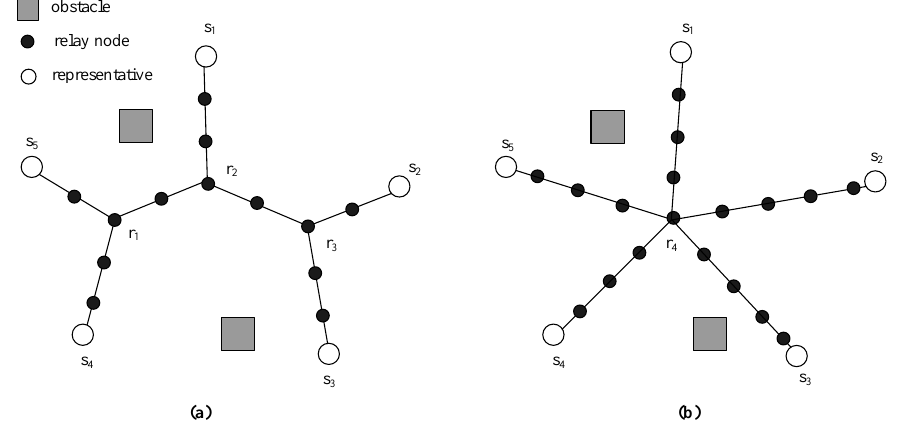
Figure 8. The comparison of the resulting topologies obtained by ( a ) OASS and ( b ) Restore Relay Lost Connectivity using zero Gradient Based Point solution (RRLC-GBP).